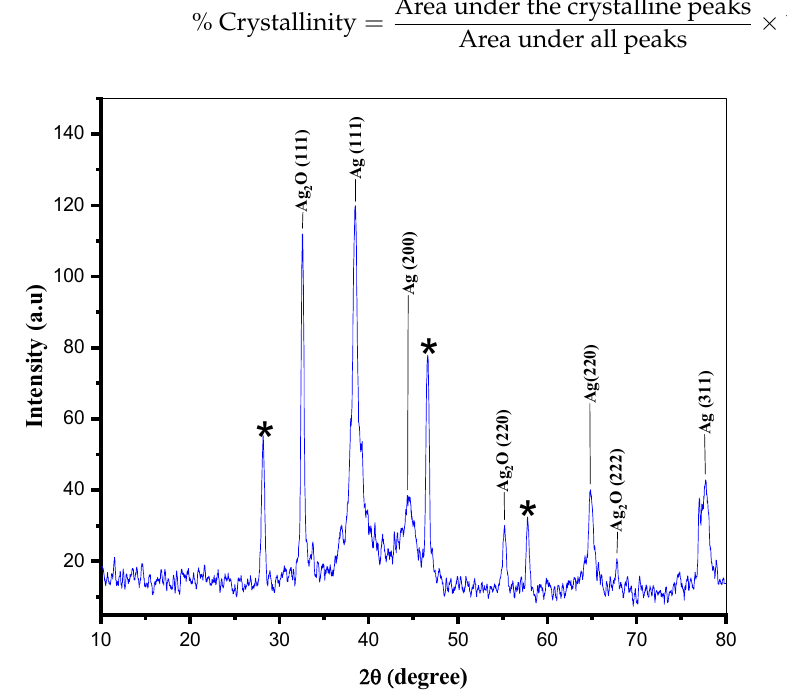
Figure 4. XRD analysis of CA-AgNPs. * Unassigned peaks.